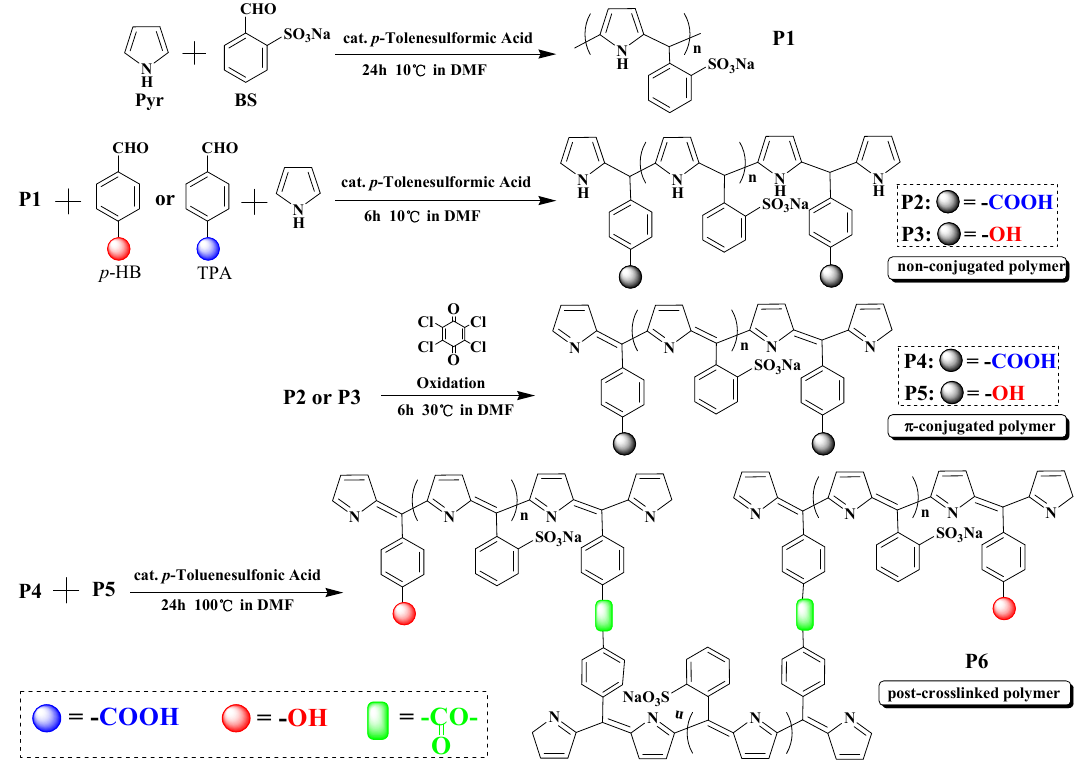
Scheme 1. Synthetic routes of narrow-band-gap polymers.